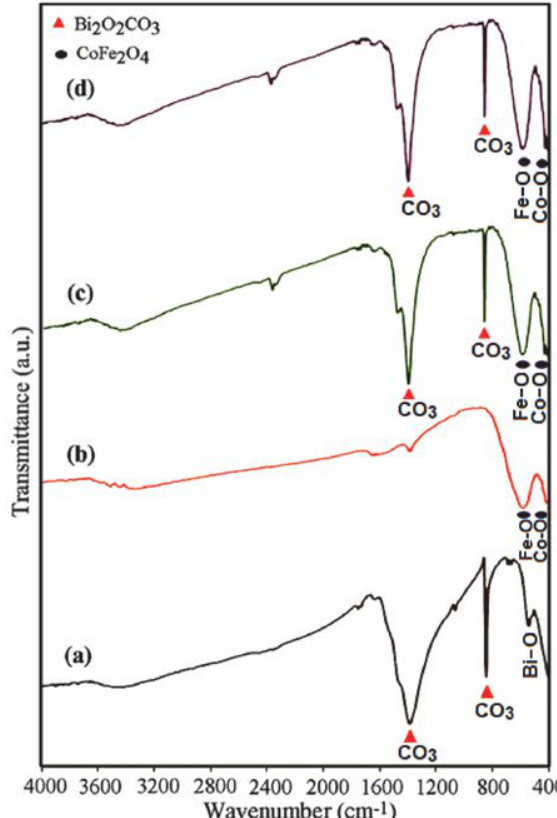
Figure 1. FT-IR spectra of (a) Bi 2 O 2 CO 3 , (b) CoFe 2 O 4 (c) Bi 2 O 2 CO 3 /CoFe 2 O 4 30%, and (d Bi 2 O 2 CO 3 /CoFe 2 O 4